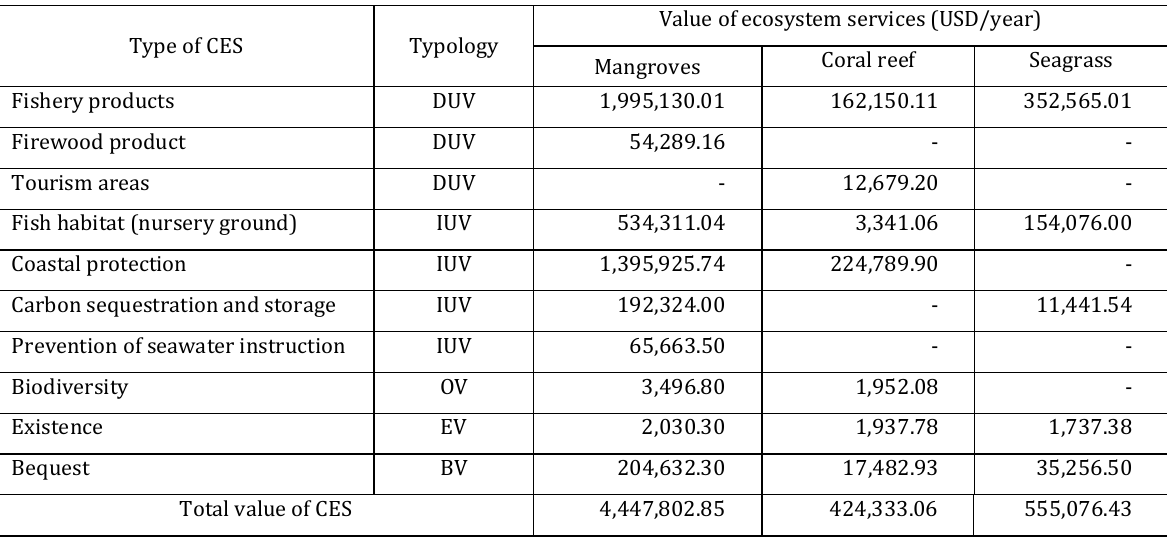
Table 3. The total value of CES in Jayapura City, Papua Province,